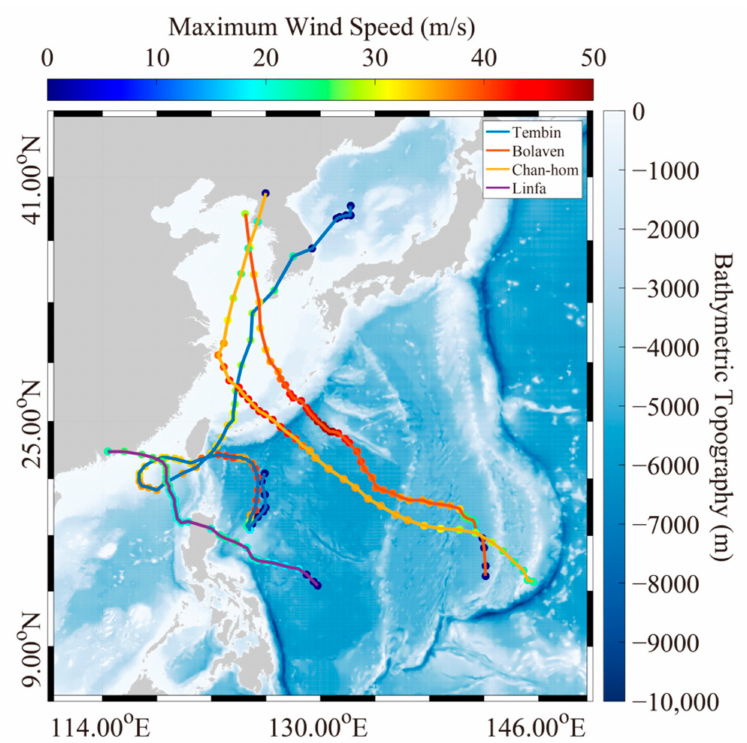
Figure 1. The tracks of the typhoons analyzed in this study superimposed on the water depth data from the General Bathymetry Chart of the Oceans